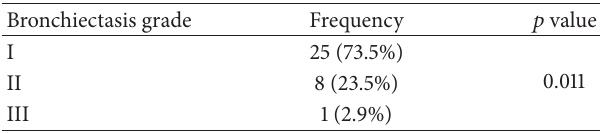
Table2:Frequencyofdifferentgradesofbronchiectasisin M.simiae pulmonary